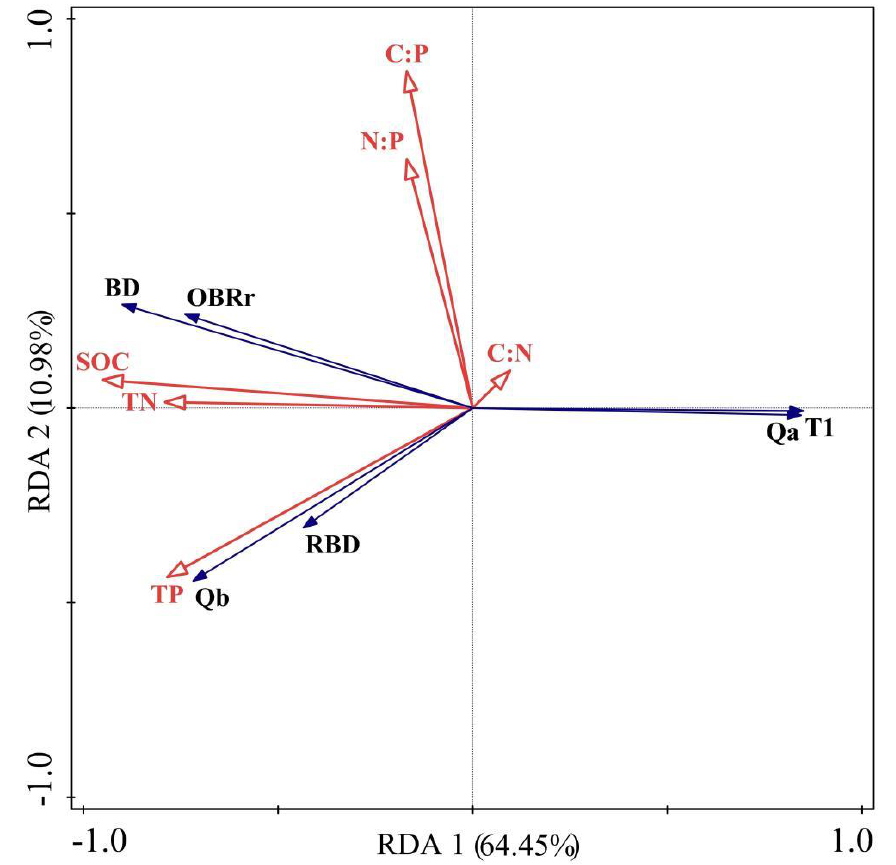
Figure 4. Redundancy analysis result of relationships between morphological characteristics of adventitious root system and soil stoichiometric characteristic factors.